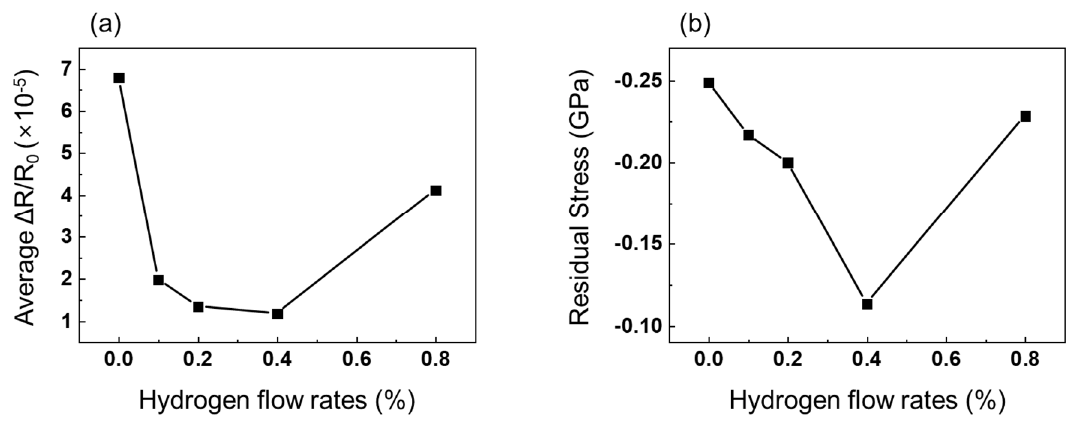
Figure 4. Mechanical properties of In − Zn − O thin films as a function of various hydrogen flow rates. ( a ) average changes in resistance ( ∆ R / R 0 ) and ( b ) residual stress of In − Zn − O thin